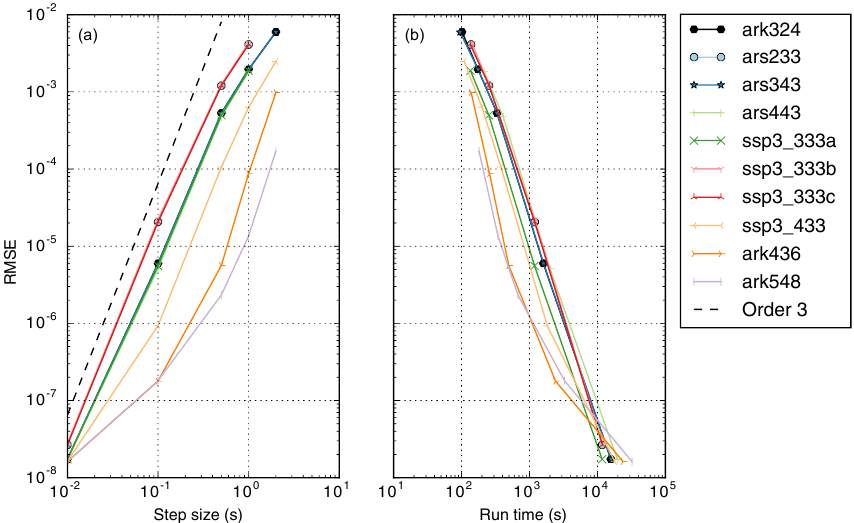
Figure 2. Accuracy (a) and efficiency (b) for the third-, fourth-, and fifth-order methods using the Rosenbrock-like approach with the HEVI- A splitting. The dashed line represents third-order convergence. Results using multiple Newton iterations to compute the stage solutions give nearly identical error values to the Rosenbrock-like results but increase the computational cost by